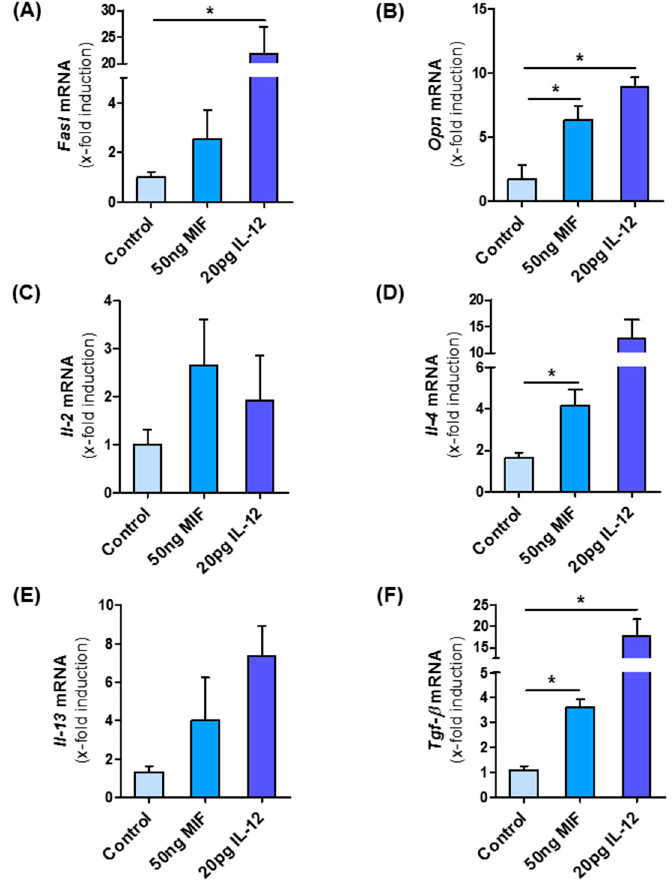
Figure 7. NKT cells are skewed to pro-fibrotic type I subpopulation by MIF. NKT cells were isolated from the spleen from untreated, 10 weeks old, male Mif − / − mice. NKT cells were isolated via one negative and one positive selection with the MACS separator. Isolated cells were stimulated in vitro with 50 ng/mL of recombinant, murine MIF and as positive control with 20 pg/mL IL-12 for 24 h. After stimulation, mRNA analysis was performed to determine the expression levels of type I NKT cell marker ( A ) Fasl and ( B ) Opn . The expression levels of ( C – E ) Interleukins and Tgf- β ( F ), which is expressed by type I NKT cells, are also determined by qRT-PCR after MIF stimulation. Experiments were performed two times with four technical replicates. Asterisks indicate statistical significance: * p <